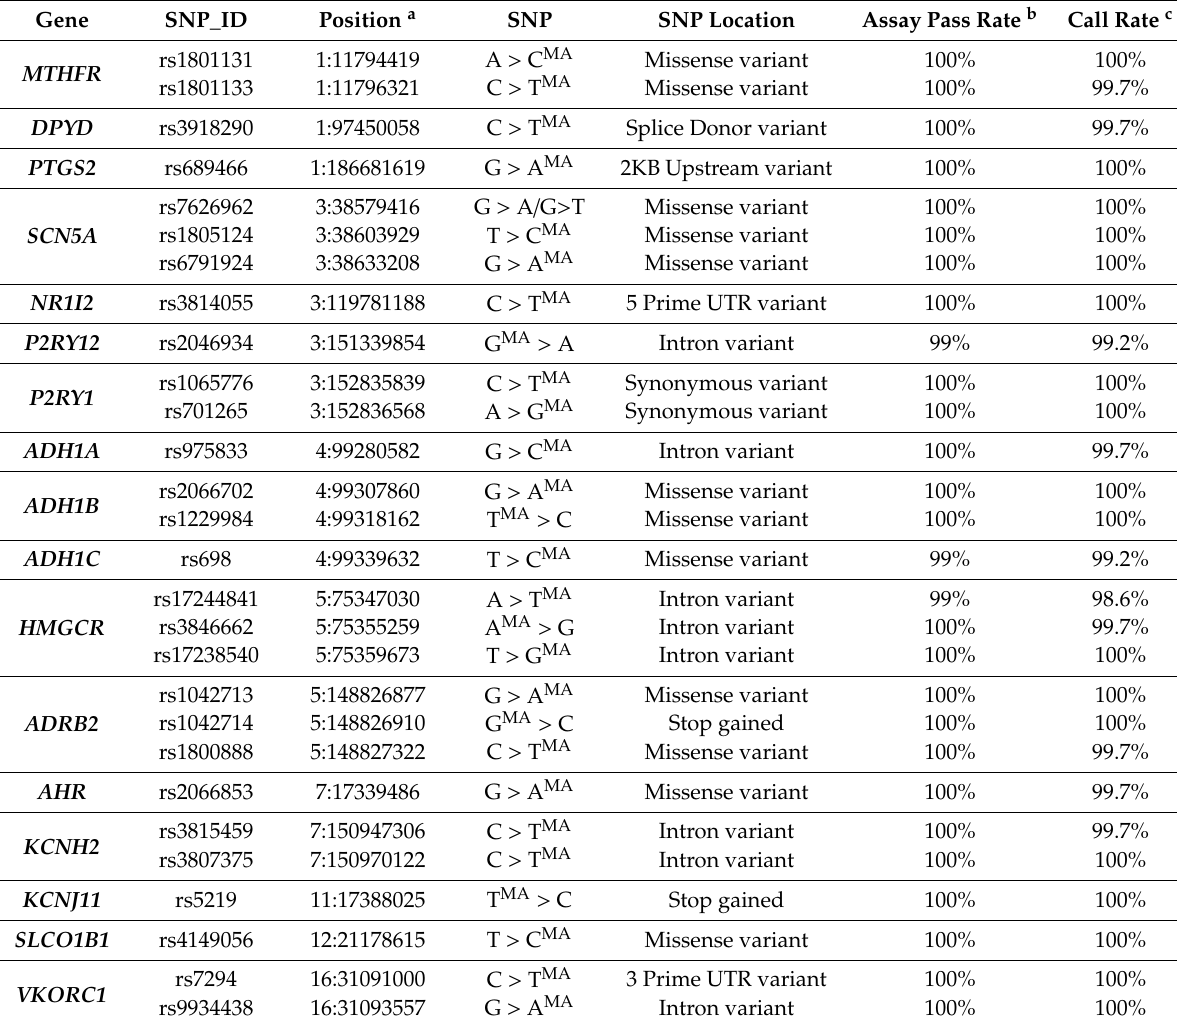
Table 1. List of genes, their single nucleotide polymorphisms (SNPs), positions and genotyping data for Circassian ( N =